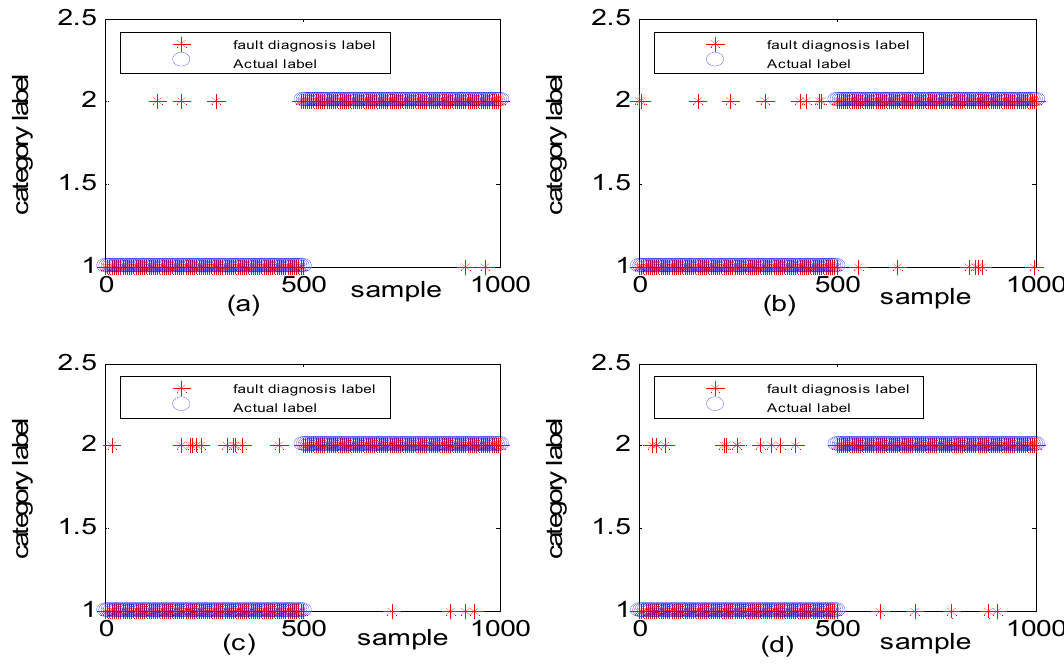
Figure 13. Simulation study for diagnosis of faults with the same frequency and different fault amplitudes: ( a ) DGFFDNN, ( b ) DNN, ( c ) DGFFBP, and ( d ) BP. A red star represents the fault diagnosis label of each online sample, and a blue circle represents the real label of each sample. At each sample time, the coincidence of a red circle and a blue star means that the online observation at this sample time is correctly diagnosed.